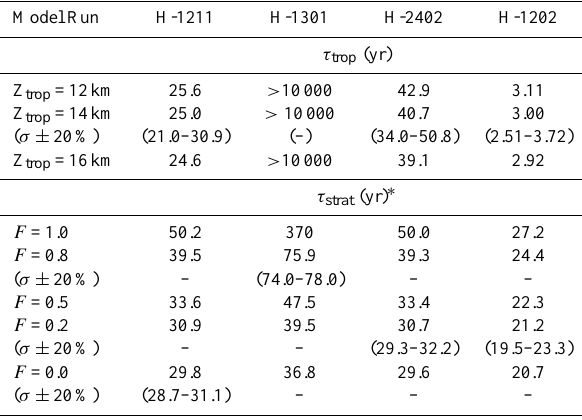
∗ Stratospheric lifetimes are only calculated for Z lifetimes at Z trop =12km and 16km can be inferred using the total lifetime (Table 4) and the tropospheric